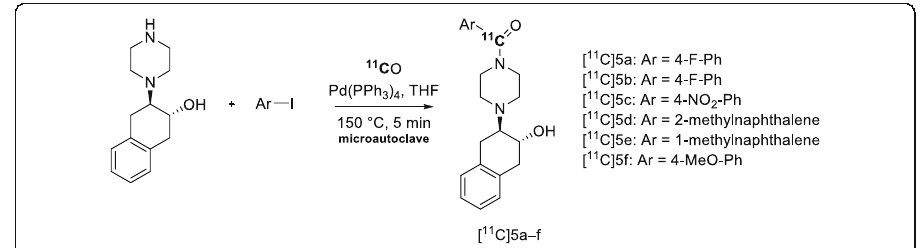
Fig. 22 11 C-Labeling with [ 11 C]carbon monoxide of potential VAChT